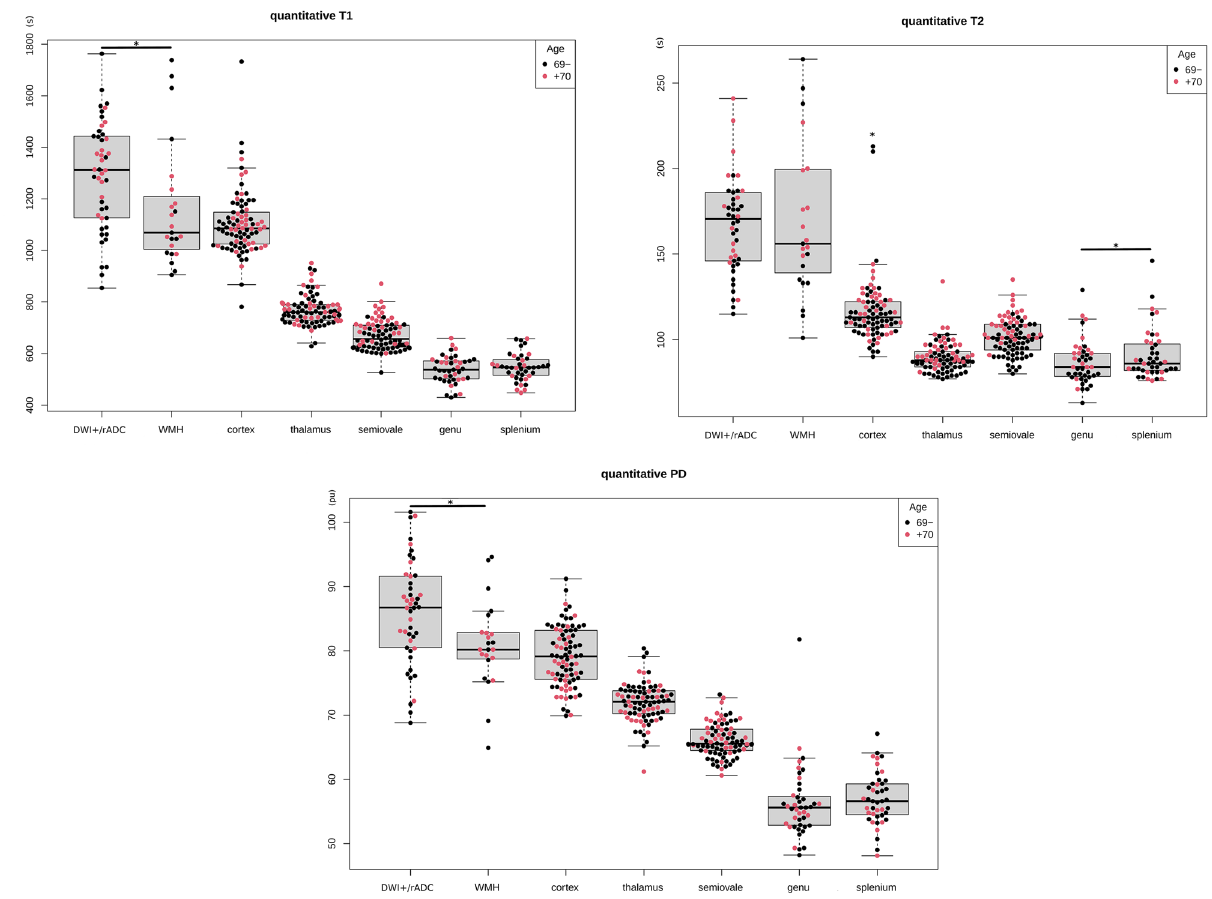
Figure 4. Beeswarm-box plots depicting quantitative synthetic findings of 46 acute (DWI + /rADC) and 23 chronic (WMH) ischemic lesions, and, 430 NBR. Significant differences ( p < 0.05) between ROI are indicated by an